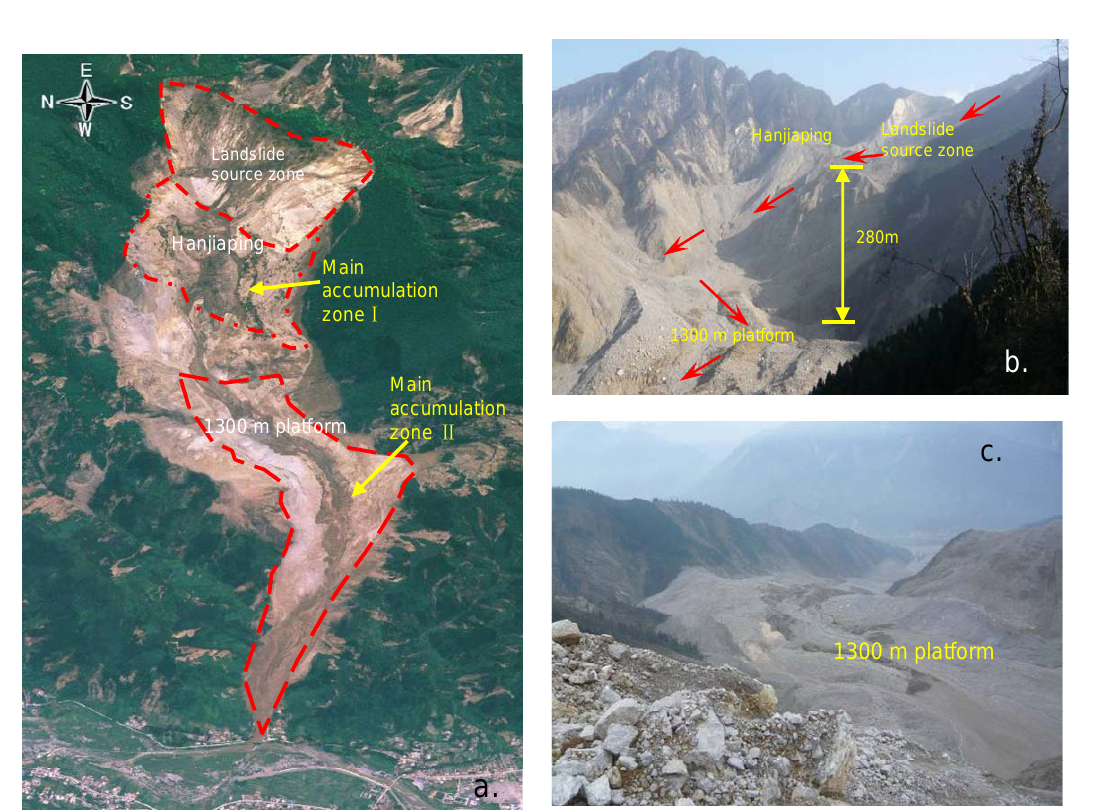
Fig. 4. Wenjia gully landslide induced by the 2008 Wenchuan Earthquake (a: aerial photograph of Wenjia gully landslide after the Wenchuan earthquake taken on May 18, 2008; b: Wenjia gully landslide source zone, and 1300 m platform; c: 1300 m platform and loose deposits below it).